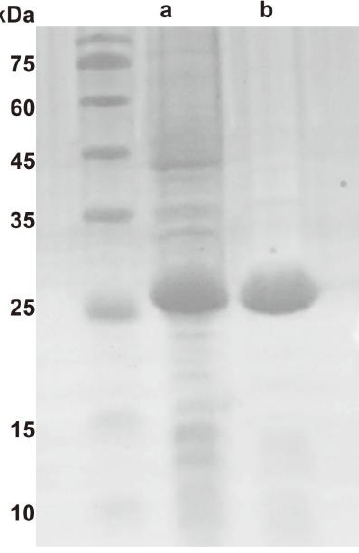
Figure 1. Detection of Ton1914 by SDS–PAGE. ( a ) Crude enzyme; ( b ) Purified protein heated at 80 °C for 10 min.